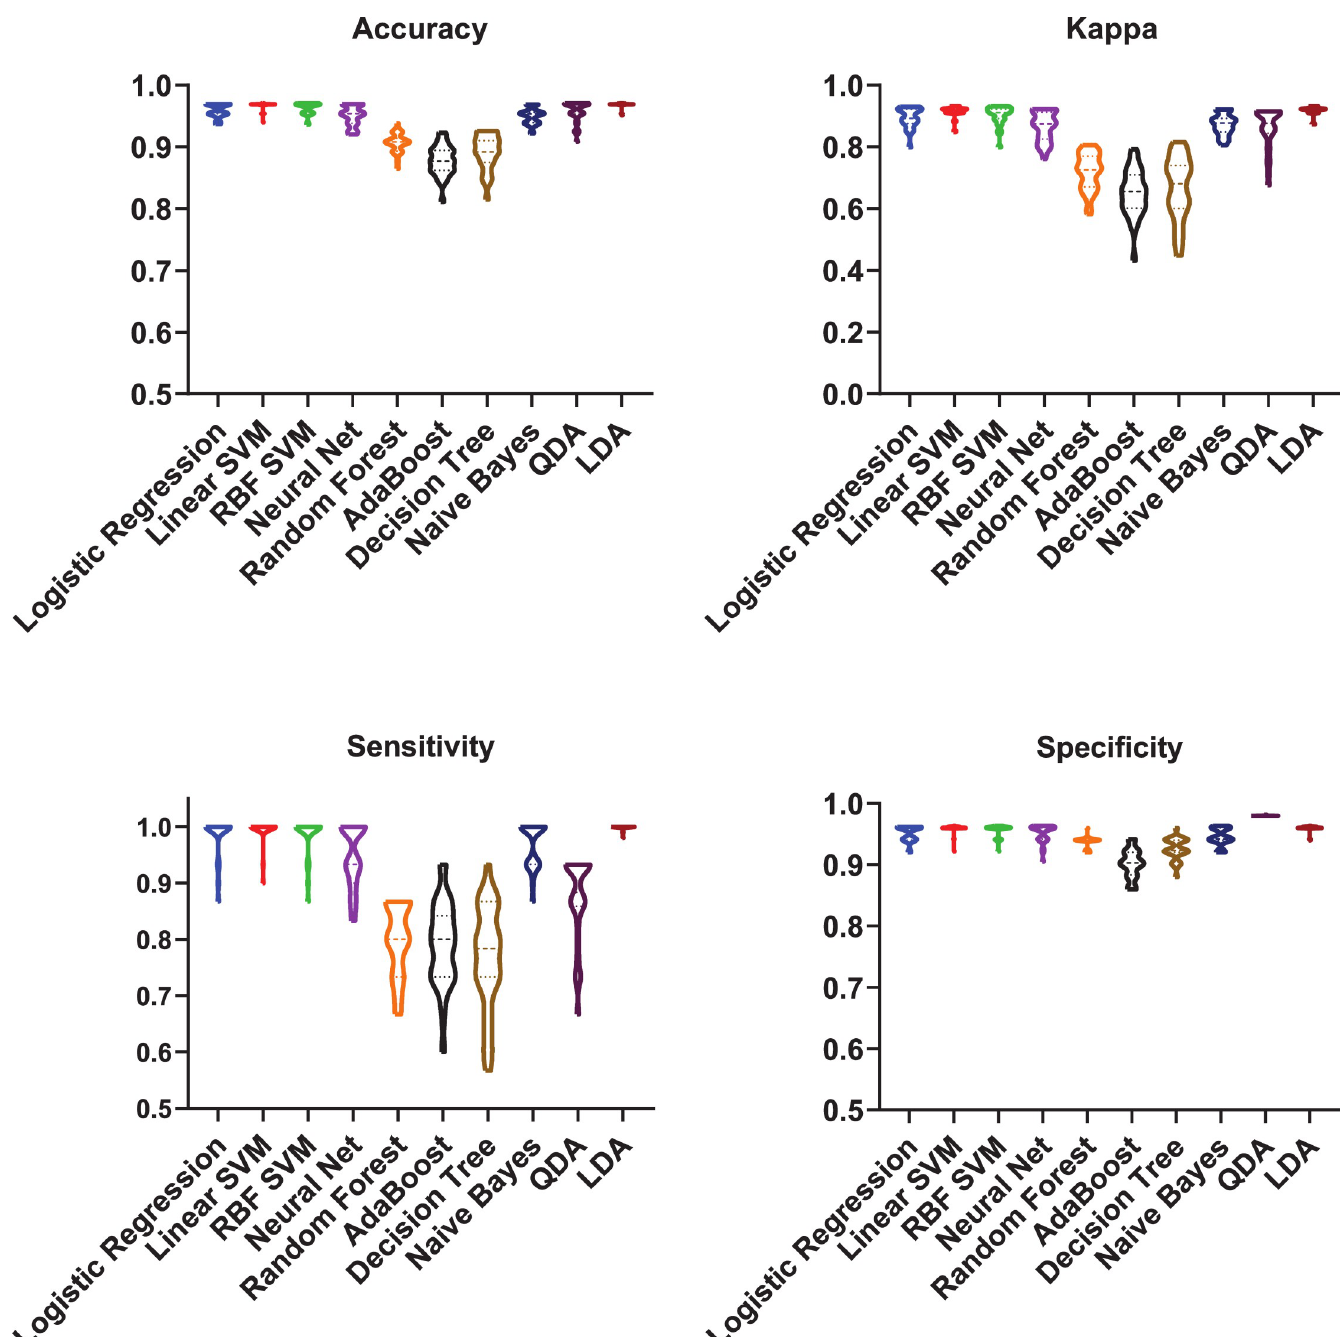
Fig 3. Supervised machine learning prediction of multidrug resistance spectral signature profiles. Prediction performance results of different classifiers (logistic regression, linear SVM, RBF SVM, MLP neural network, decision tree, random forest, AdaBoost, na ï ve Bayes, quadratic discriminant analysis (QDA) and linear discriminant analysis (LDA)) that were used to classify the multidrug resistance profiles are shown on the X-axis. Four performance indicators have been used to evaluate the classification: accuracy, kappa, sensitivity and specificity. The scores for each performance metric are indicated in the Y-axis.